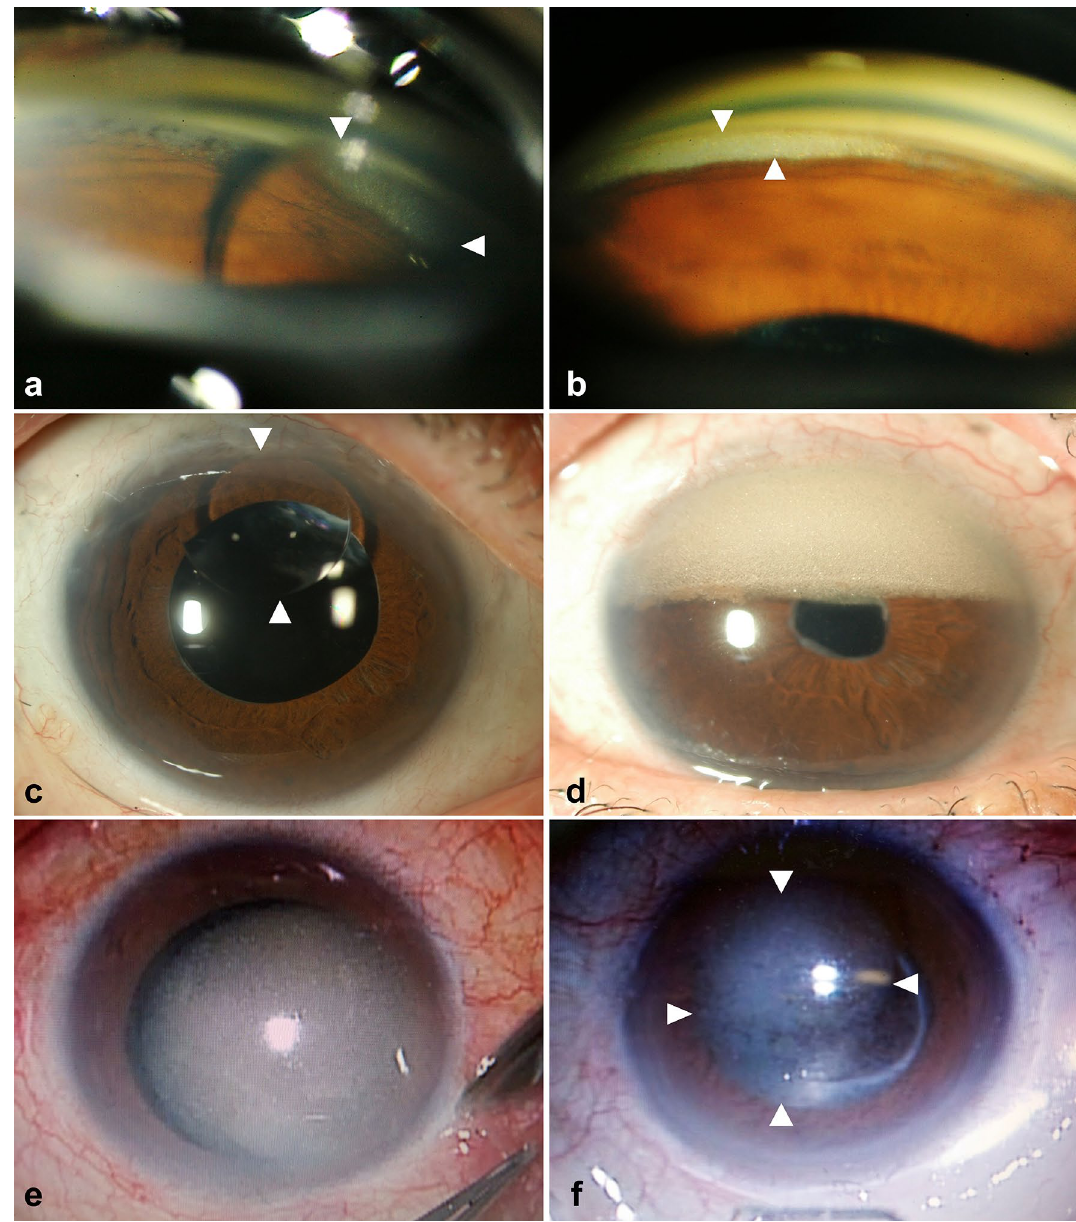
Figure 1. Anterior chamber silicone oil (SO) observation with gonioscope, slit lamp, and surgical microscope. Anterior chamber SO was observed with gonioscope in 19 eyes of 29 eyes. SO droplet was observed in the 1 o’clock angle direction by the gonioscope ( a ). A case in which fine particles and muddy SO are present in the upper angle only when seen with a gonioscope ( b ). Anterior chamber SO was observed with slit lamp in 13 eyes of 54 eyes. A case in which SO droplets are easily found in the anterior chamber by normal slit lamp microscopy examination ( c ). A case that seems to occupy approximately the upper half of the anterior chamber to the turbid fine granular SO ( d ). Anterior chamber SO was observed with surgical microscope at beginning of SO removal surgery in 33 eyes of 53 eyes. Because the patients are in supine position during surgery, SO present in the anterior chamber can be easily observed ( e , f ).